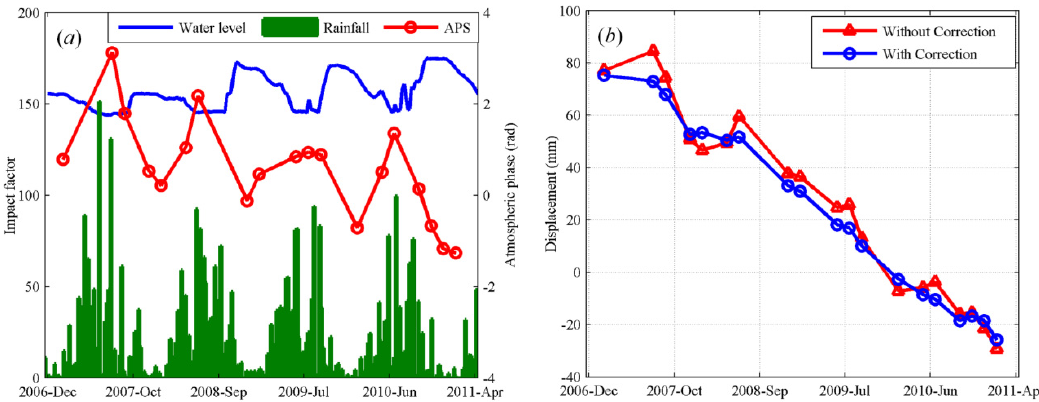
Figure 10. ( a ) Estimated atmospheric signal on P1 and impact factors: water level (unit: m) and rainfall (unit: mm), the dashed line represents the temporal location of the master image. ( b ) Time series displacements on P1 with and without stratified APS correction.